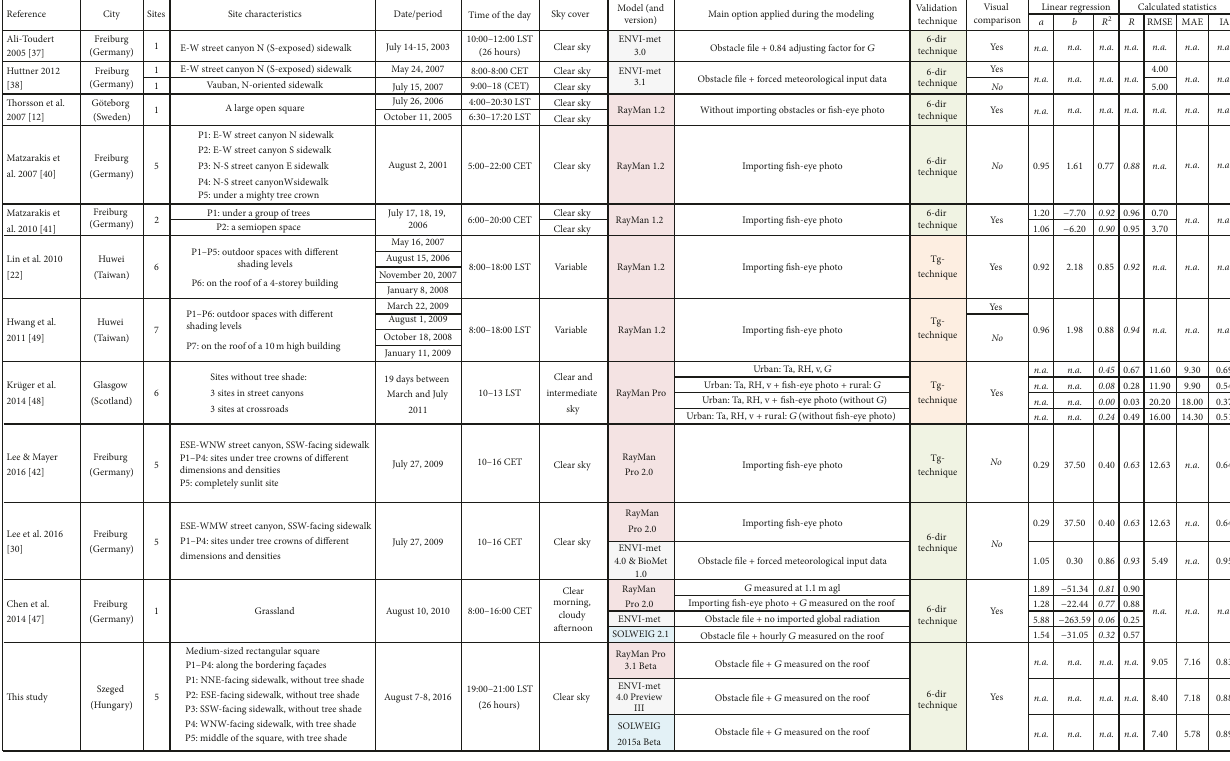
Figure 9: Data extracted from previous model validation studies ( 6-dir technique: filed measurements utilizing pyranometers and pyrgeometers (or net radiometers as an alternative) to obtain short-and long-wave radiation flux densities from six perpendicular directions; Tg-technique: field measurements utilizing globe-thermometers together with air temperature and wind velocity measurements; 𝑎 and 𝑏 : coefficients of linear regressions T = 𝑎×𝑇 + 𝑏 ; 𝑅 2 : coefficient of determination; 𝑅 : Pearson’s correlation coefficient; RMSE: mrt(modeled) mrt(measured) root mean square error; MAE: mean absolute error; IA: Willmott’s index of agreement; note: n.a. as well as other cells written in italics font indicate data that were not available in the cited